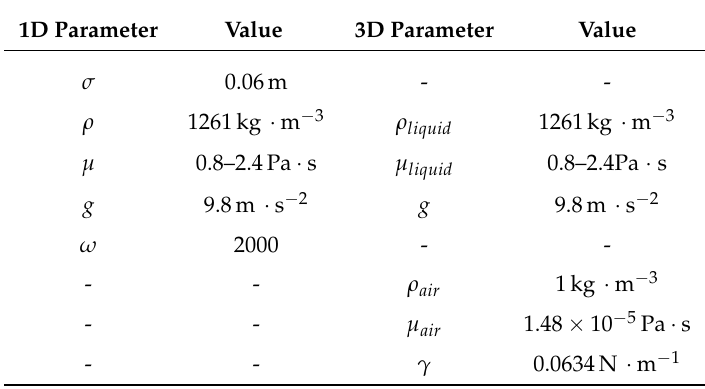
Table 1. Parameter values for the 1D and 3D